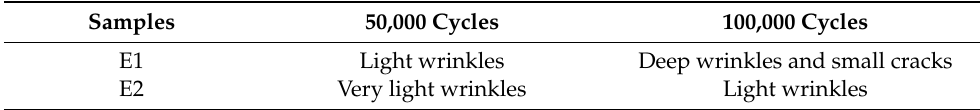
Table 5. Flex resistance of leather